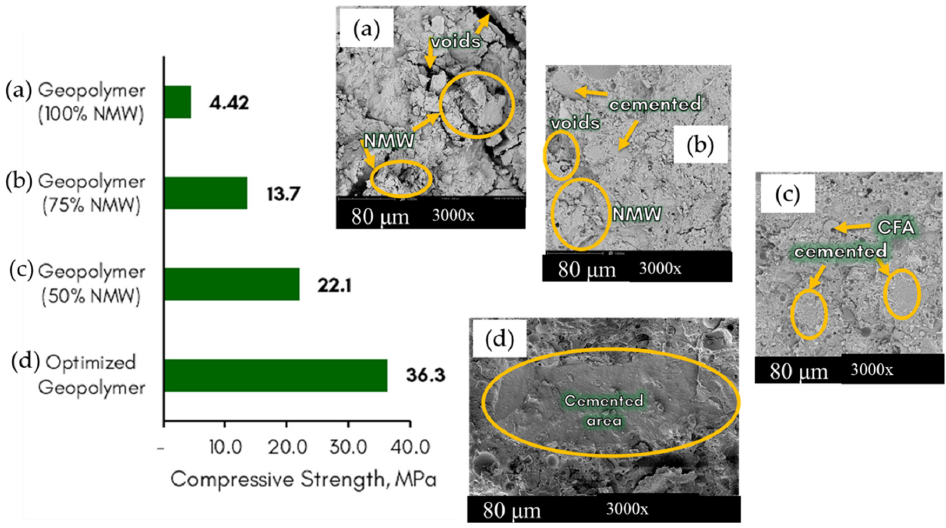
Figure 8. SEM images of synthesized geopolymer at different precursor mix (1000×) with corresponding UCS.